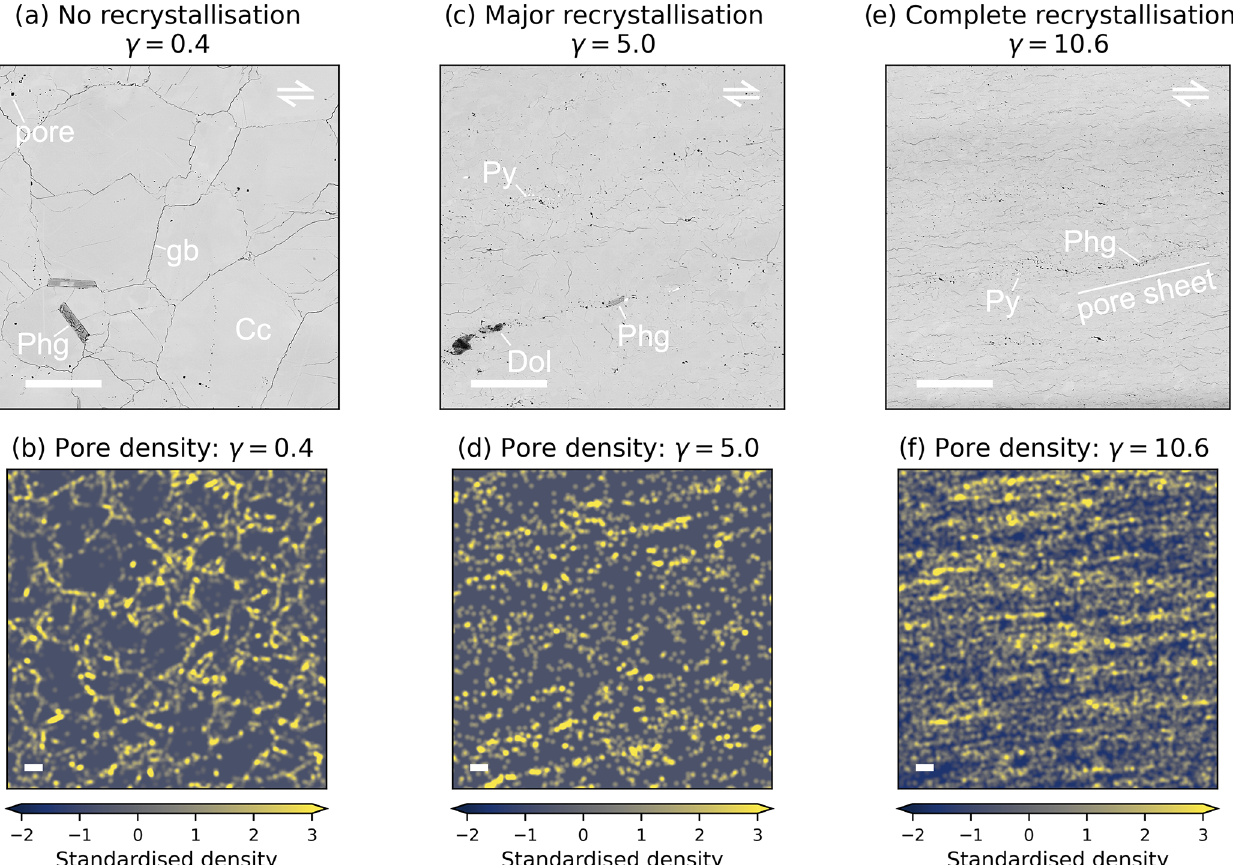
Figure 1. Microstructure and pore density in samples with increasing strain. The samples document the production of a mylonite through dynamic recrystallisation. Panels (a) , (c) and (e) are backscatter electron images while (b) , (d) and (f) are pore density maps. In all images the white scale bar is 100µm. The pointed ends of the colour bars refer to the fact that some data values are larger than the max and min of the colour map (Py – pyrite, Dol – dolomite, Phg – phengite, Cc – calcite, gb – grain boundary).